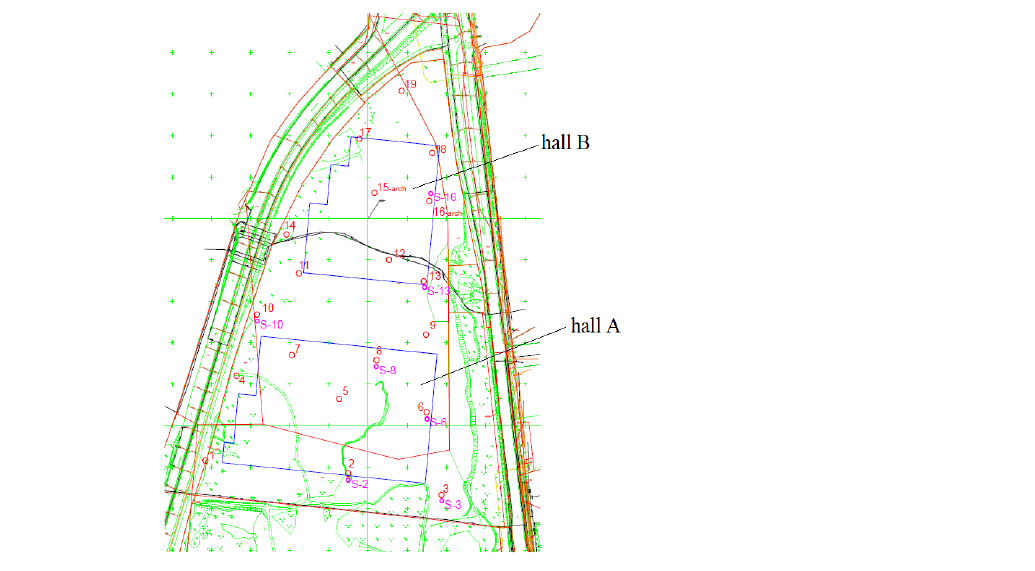
Figure 4. Documentation map of the area for the construction of production and warehouse halls in Ruda Ś l ą ska [18].